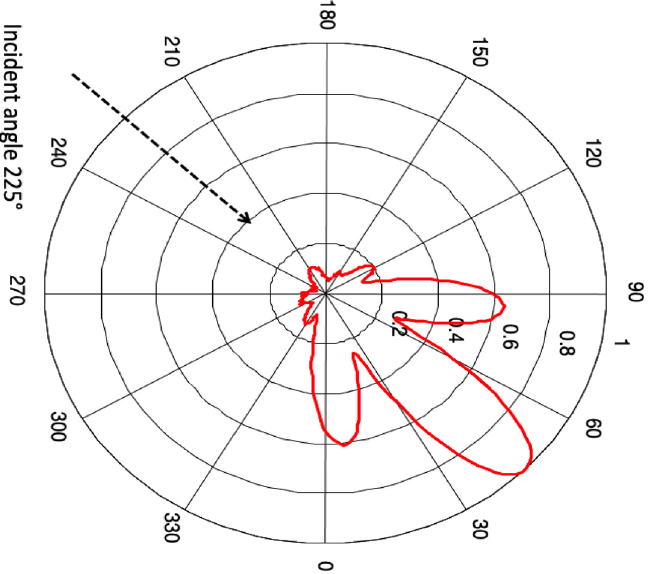
Figure 12. Directivity pattern of the scattered field of the A 0 mode deduced from total displacement fields on intact and damaged CFRC plates (See Figures 10 and 11).